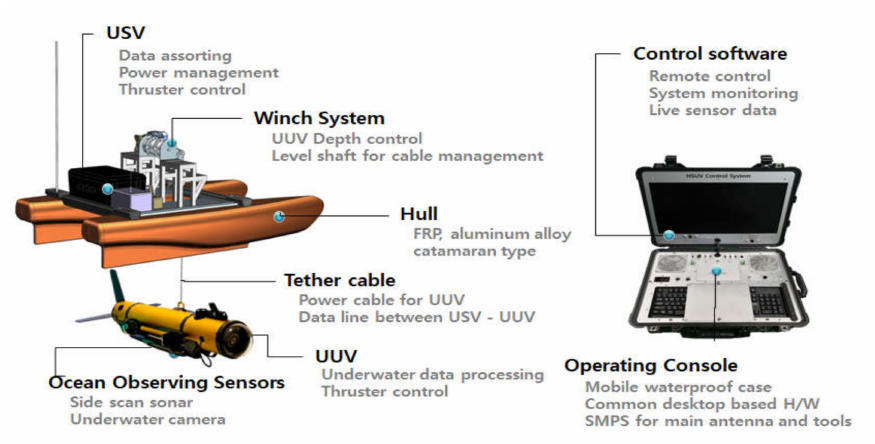
Figure 2. Components of the integrated system. USV, unmanned surface vehicle; UUV, unmanned underwater vehicle, operating console.